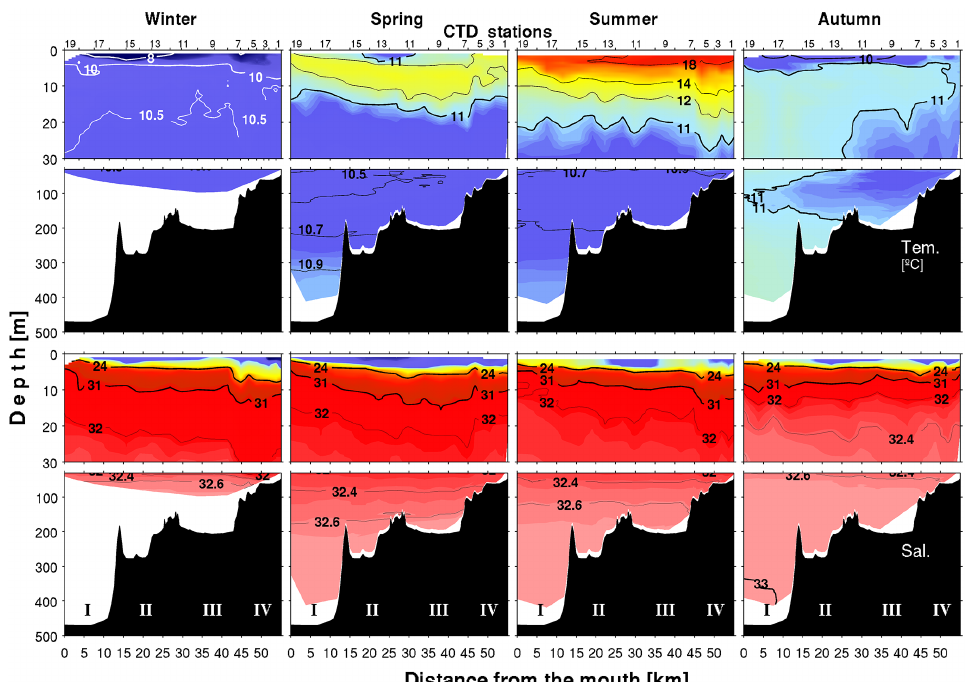
Figure 4. Along-fjord seasonal distribution of temperature (above) and salinity (below) for winter, spring, summer and autumn. The figure includes the CTD station number in the top of each panel and the sub-basins numbers below.